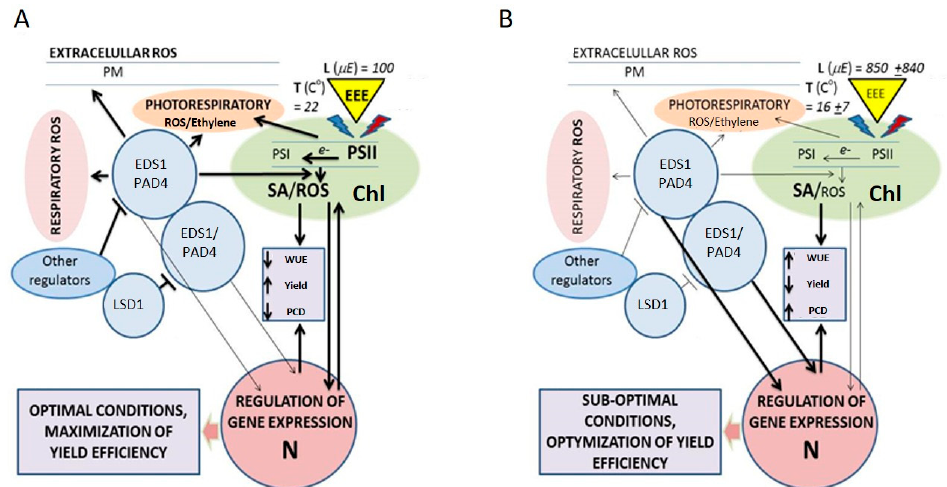
Figure1. Proposedmodelsofregulationandintegrationofseedyield, maximalphotosynthetice ffi ciency, Figure 1. Proposed models of regulation and integration of seed yield, maximal photosynthetic reactive oxygen species (ROS) / hormonal cellular homeostasis and water use e ffi ciency by LESION efficiency, reactive oxygen species (ROS)/hormonal cellular homeostasis and water use efficiency by SIMULATING DISEASE 1 (LSD1) / ENHANCED DISEASE SUSCEPTIBILITY 1 (EDS1) / PHYTOALEXIN LESION SIMULATING DISEASE 1 (LSD1)/ENHANCED DISEASE SUSCEPTIBILITY 1 DEFICIENT 4 (PAD4) in Arabidopsis . LSD1 / EDS1 / PAD4 is proposed to function as a regulatory hub in (EDS1)/PHYTOALEXIN DEFICIENT 4 (PAD4) in Arabidopsis . LSD1/EDS1/PAD4 is proposed to laboratory ( A ) and field ( B ) conditions. Bold lines—strong regulation, thin lines—weak regulation. function as a regulatory hub in laboratory (A) and field (B) conditions. Bold lines—strong regulation, WUE—water use e ffi ciency, Yield—seed yield. Average light intensity ( µ mol of photons m − 2 s − 1 ) and thin lines—weak regulation. WUE—water use efficiency, Yield—seed yield. Average light intensity temperature ( ◦ C) are given on the triangle borders that symbolize the capacity of the photosystems to (µmol of photons m -2 s -1 ) and temperature (°C) are given on the triangle borders that symbolize the absorb excess light energy (EEE). Chloroplast (Chl), nucleus (N), photosystem II and I (PSII and PSI), capacity of the photosystems to absorb excess light energy (EEE). Chloroplast (Chl), nucleus (N), plasma membrane (PM), reactive oxygen species (ROS) and salicylic acid photosystem II and I (PSII and PSI), plasma membrane (PM), reactive oxygen species (ROS) and salicylic acid (SA).